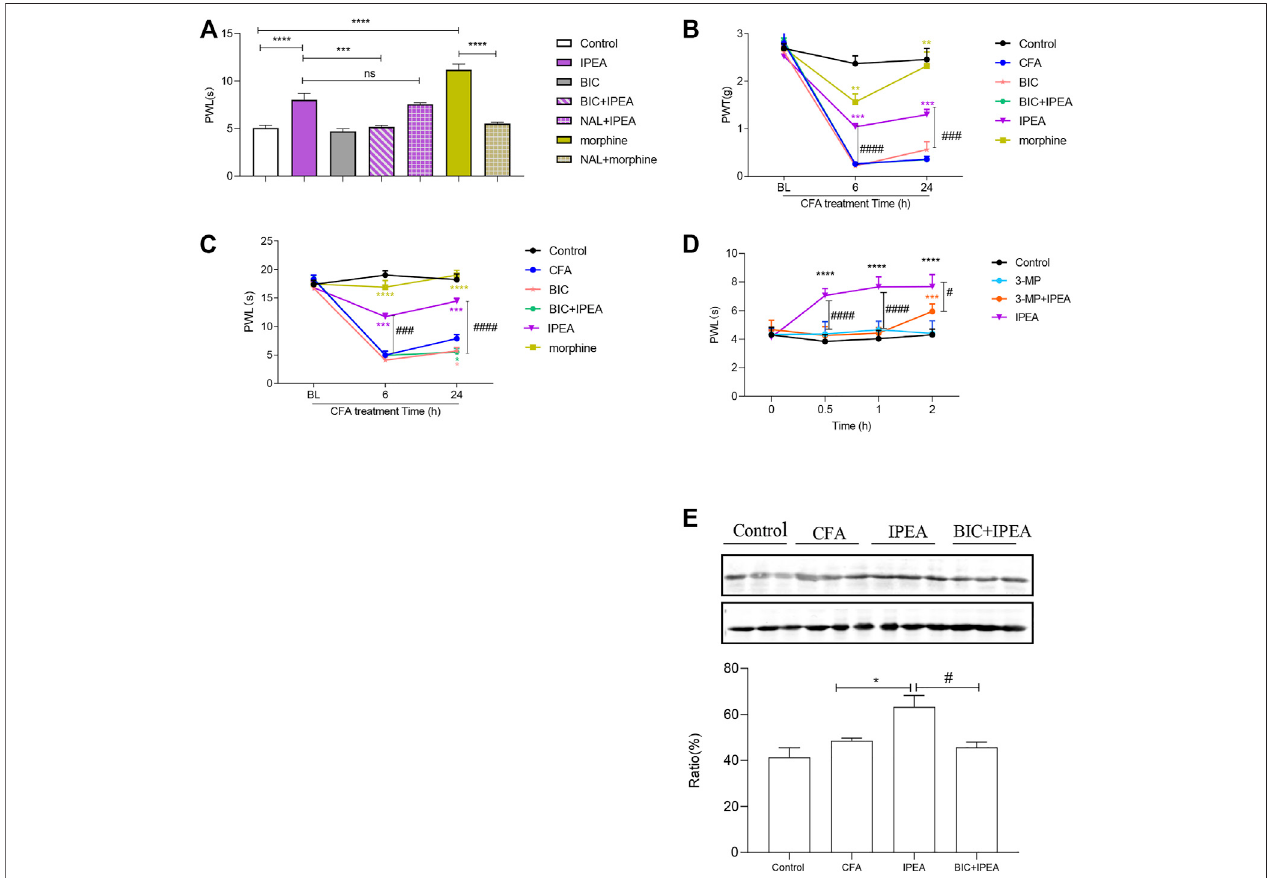
FIGURE4| ThemechanismofIPEAactioninmediatinganalgesiceffects. (A) IPEAmediatedanalgesiathroughGABA A Rinanacutepainmousemodel.Micewere pretreated with BIC (1 mg/kg, i. p.) for 30 min or naloxone (NAL, 1 mg/kg, opioid receptor antagonist) for 5 min, followed by 20 mg/kg IPEA administration. PWL was measured 1 h after IPEA treatment in the hot plate assay. Unpaired t test was used. *** p < 0.001, comparison as indicated. ns, not signi fi cant (B,C) IPEA mediated analgesia through GABA A receptor in a CFA-induced in fl ammatory pain mouse model. PWL and PWT were determined 1 h after IPEA treatment. Mice were pre- treatedwithBIC(1 mg/kg,i.p.)for30min,followedby20 mg/kgIPEAadministration.Two-wayANOVArevealedsigni fi cantdrugeffects( (B) :F5,30 (cid:2) 39.42, p < 0.0001; (C) : F5, 30 (cid:2) 97.55, p < 0.0001) and time effects ( (B) : F1.692, 50.77 (cid:2) 323.6; (C) : F1.889, 56.66 (cid:2) 153.0, p < 0.0001) followed by Dunnett post hoc test. ** p < 0.01, *** p < 0.001, **** p < 0.0001 vs CFA group; # p < 0.05, ### p < 0.001, #### p < 0.0001, comparison as indicated. (D) Mice were pretreated with 3-MP (10 mg/kg) for 30 min,followedby20 mg/kg IPEA.PWLofmicewasmeasured atdifferenttimepointsinthehotplateassay.Two-way ANOVA revealedsigni fi cantdrugeffects(F3,28 (cid:2) 64.01, p < 0.0001) and time effects (F2.568, 71.90 (cid:2) 17.07, p < 0.0001) followed by Dunnett post hoc test. *** p < 0.001, **** p < 0.0001 vs saline control group; # p < 0.05,#### p < 0.0001,comparisonasindicated. (E) TheexpressionlevelsofGABA A R α 2inthespinalcordofCFA-inducedin fl ammatorypainmice.Micewerepretreated withIPEA(20 mg/kg)for1 handthespinalcordwascollected24 hafterCFAtreatment.Unpaired t testwasused.TheexpressionlevelsofGABA A R α 2inthespinalcord were determined by western blot. * p < 0.05, # p < 0.05, comparison as indicated. Data were obtained from three independent experiments and expressed as the means ± SEM ( n (cid:2) 6 – 8 mice per